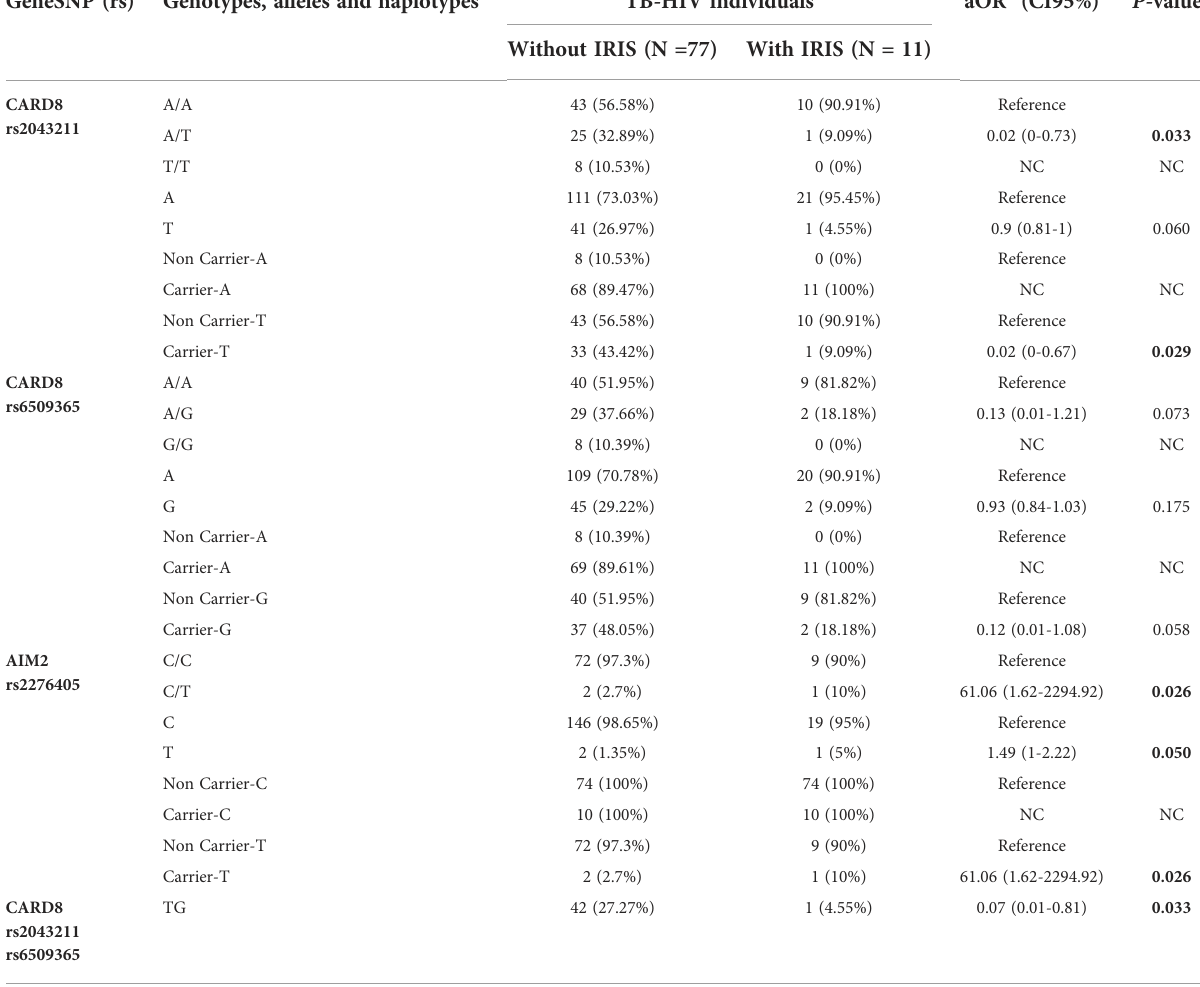
TABLE 3 Unconditional logistic multiple regression model of risk and protection factors for TB-HIV/IRIS among TB-HIV individuals. GeneSNP (rs) Genotypes, alleles and